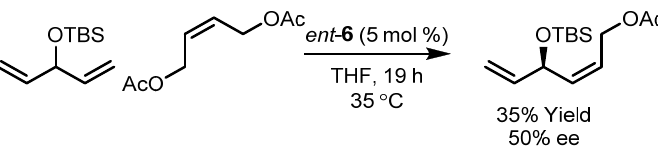
Figure 15. Stereochemical model illustrating the steric environment governing stereoretentive OM. Table 20. Effects of N -aryl ortho -substituents on the reactivity of stereoretentive olefin methathesis